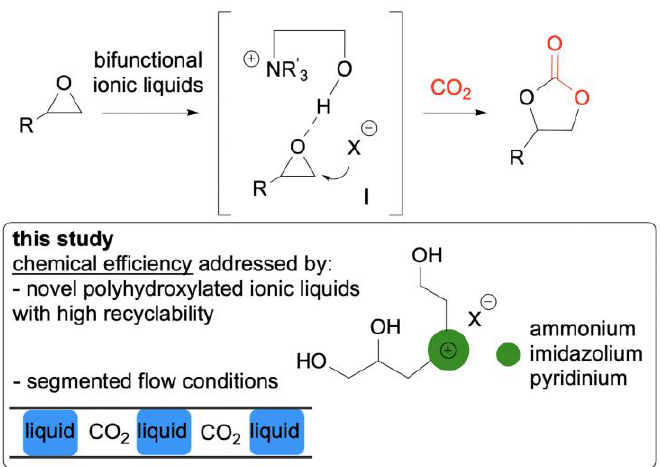
Figure 1. Design of the organocatalytic conversion of CO 2 into cyclic carbonates under segmented flow conditions.